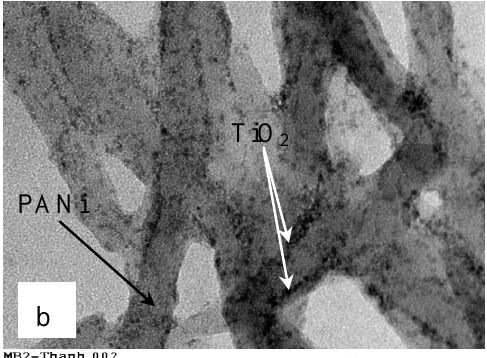
/PANi nanocomposite show the appearance of TiO 2